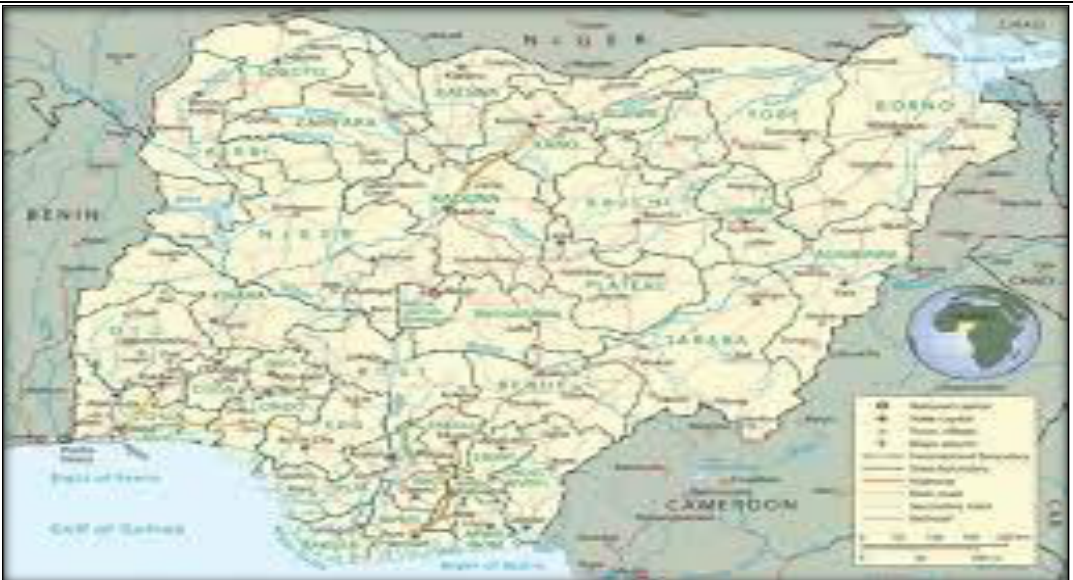
Figure 1. Map of Nigeria.